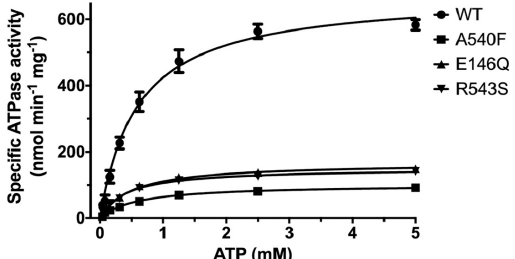
Figure 5. ATP dependence of ABCG5 / G8 ATPase activity. Purified proteins were assayed in the presence of E. coli polar lipids, and the specific activities of ATP hydrolysis were obtained from the ATP concentration-dependent experiments (0–5 mM ATP). The curves are fitted to the Michaelis–Menten equation (Prism 8), and, using two-to-four independently purified proteins, the means of at least three independent experiments along with standard deviations are plotted here. The kinetic parameters are listed in Table 1.